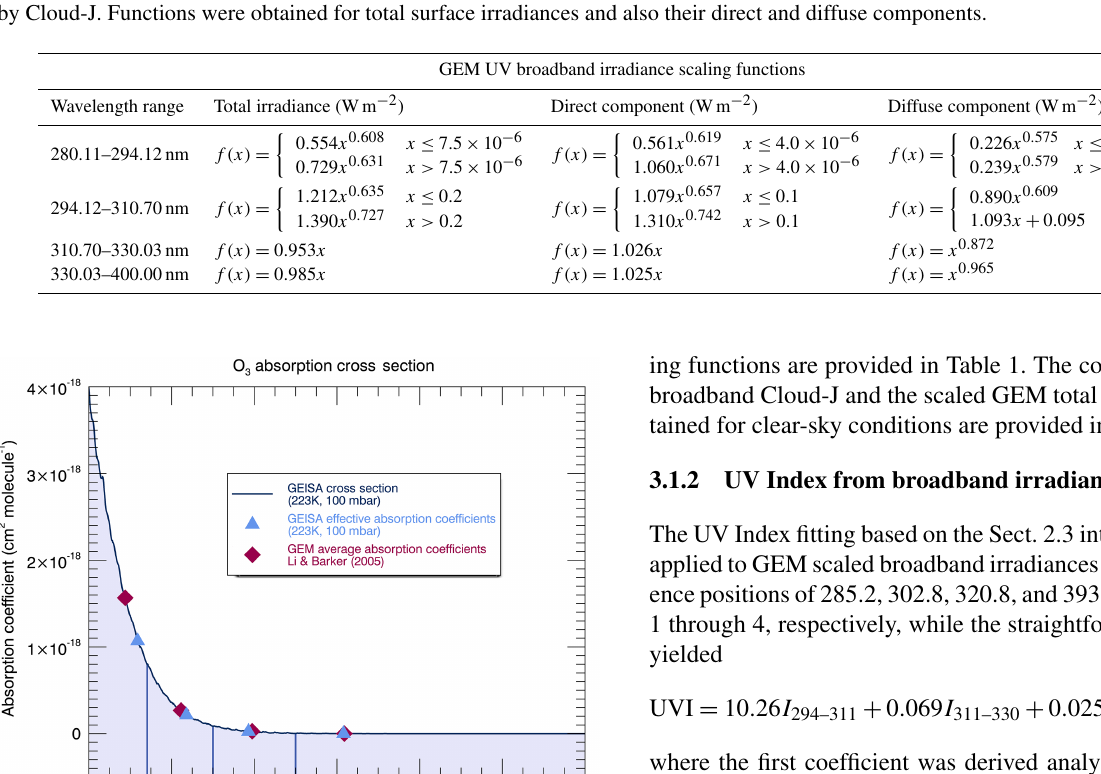
Table 1. Sets of scaling functions to calibrate the GEM UV broadband irradiances to emulate the simulated broadband irradiances produced by Cloud-J. Functions were obtained for total surface irradiances and also their direct and diffuse components.